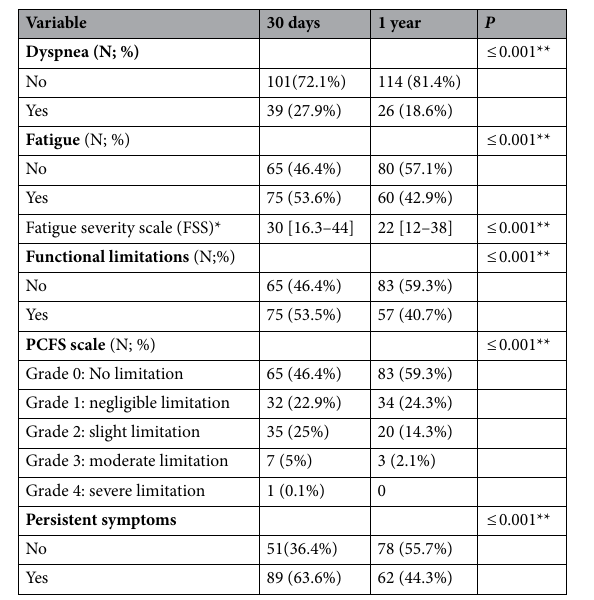
Table 2. Dyspnea, fatigue, functional limitations and persistent symptoms 30 days and one year after COVID- 19 diagnosis. Source : Prepared by the authors (2022). Chart legend: *Md [1st and 3rd q]; ** P ≤ 0.05. For comparisons between groups, the independent t test or the Mann ‒ Whitney U test was